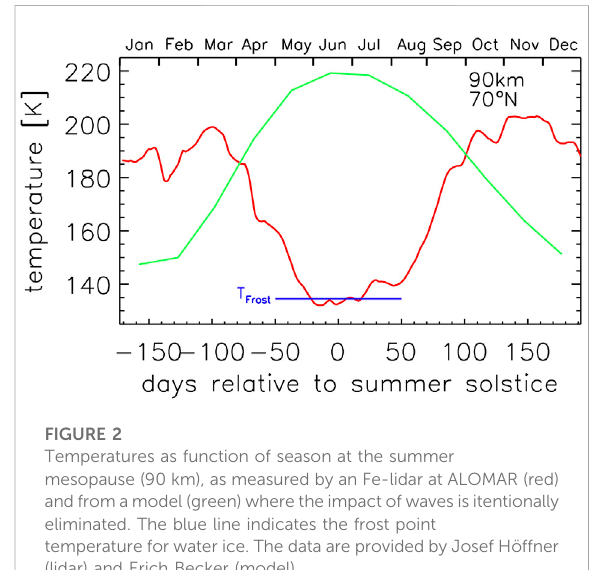
FIGURE 2 Temperatures as function of season at the summer mesopause (90 km), as measured by an Fe-lidar at ALOMAR (red) andfrom amodel (green)where theimpactofwavesisitentionally eliminated. The blue line indicates the frost point temperature for water ice. The data are provided by Josef Höffner (lidar) and Erich Becker